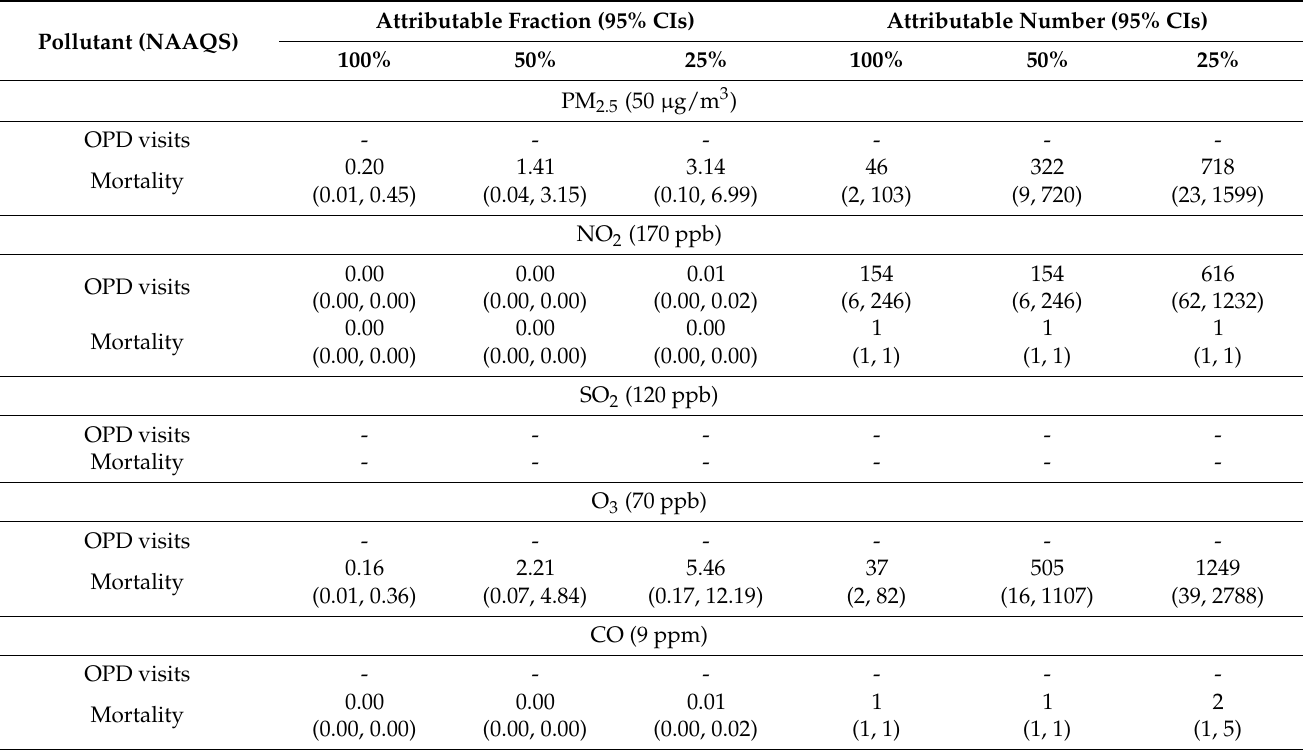
Table 7. Attributable fractions and attributable numbers of outpatient department (OPD) visits